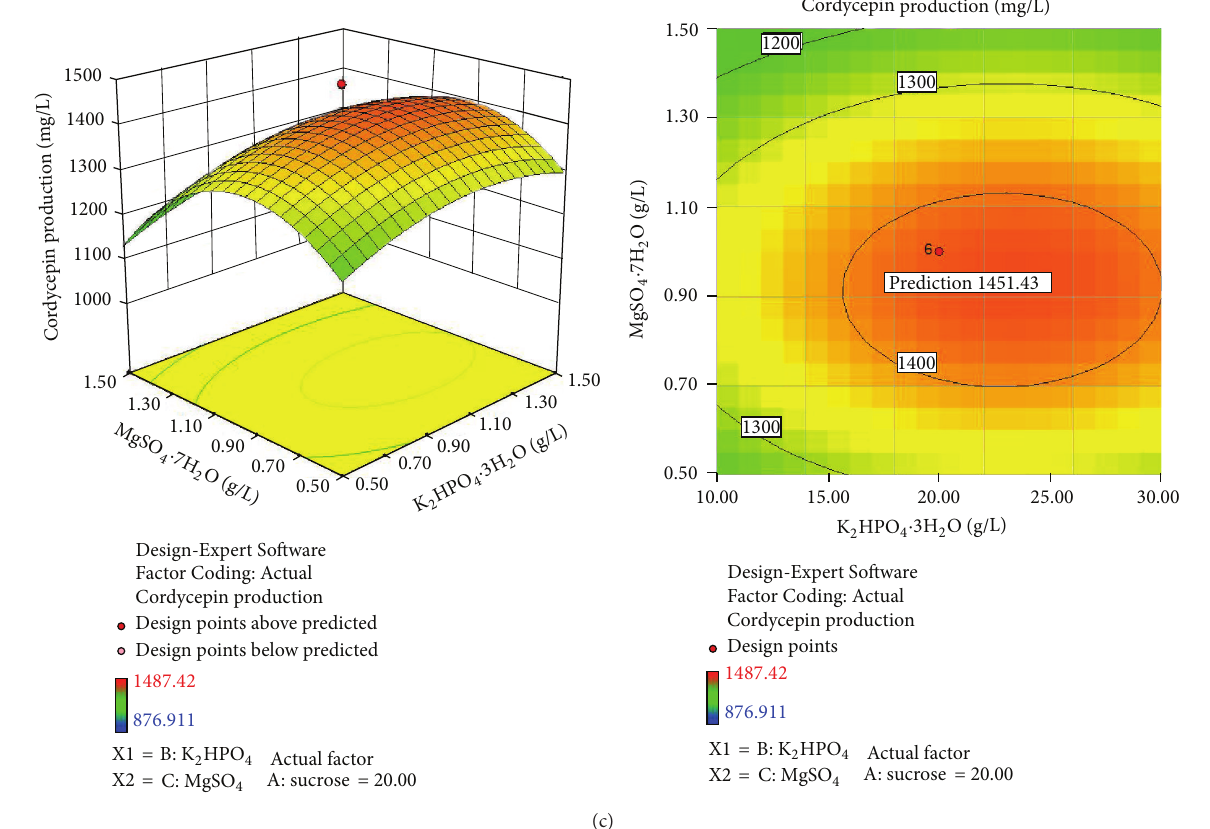
Figure 4: Three-dimensional response surface plots and two-dimensional contour plots for cordycepin production by C. militaris (strain CGMCC2459) showing variable interactions of (a) sucrose and K 2 HPO 4 ⋅ 3H 2 O; (b) sucrose and MgSO 4 ⋅ 7H 2 O; (c) K 2 HPO 4 ⋅ 3H 2 O and MgSO 4 ⋅ 7H 2 O.